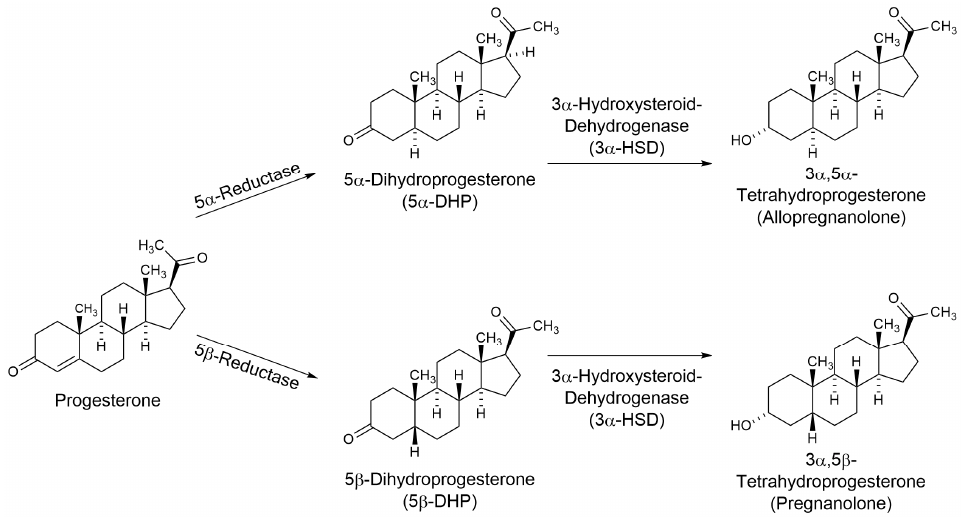
Figure 1. Biochemical pathways for the synthesis of allopregnanolone and